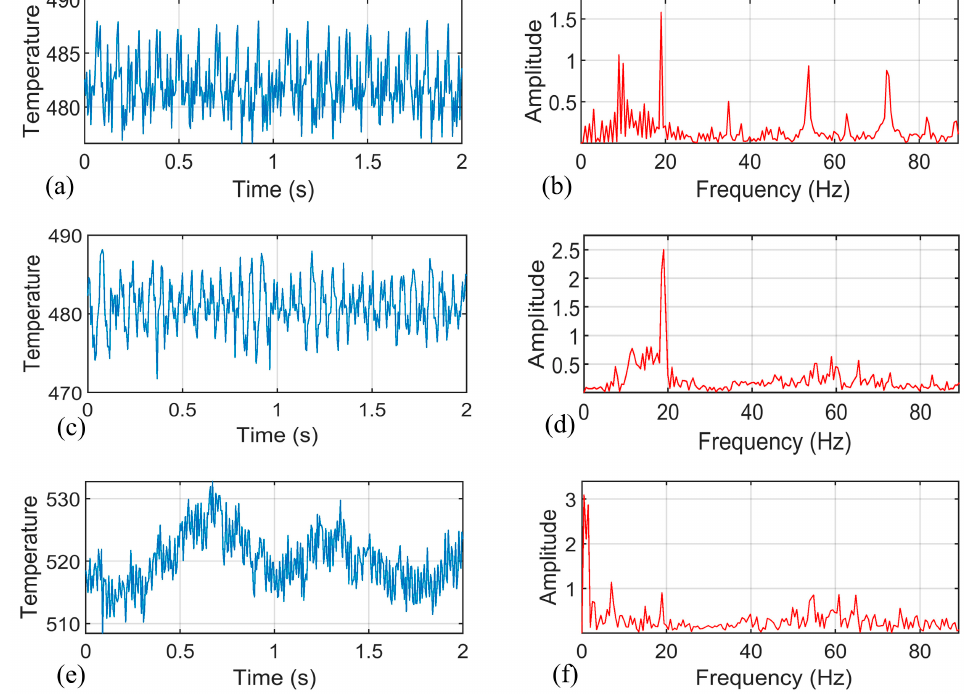
Figure 5. Raw data of temperature signal: ( a ) Temperature signal of the perfect joint; ( b ) Spectrum of the temperature signal of the perfect joint; ( c ) Temperature signal after sudden perturbation; ( d ) Spectrum of temperature signal after sudden perturbation; ( e ) Temperature signal of the joint with abnormal workmanship; and ( f ) Spectrum of the temperature signal of the joint with abnormal workmanship.